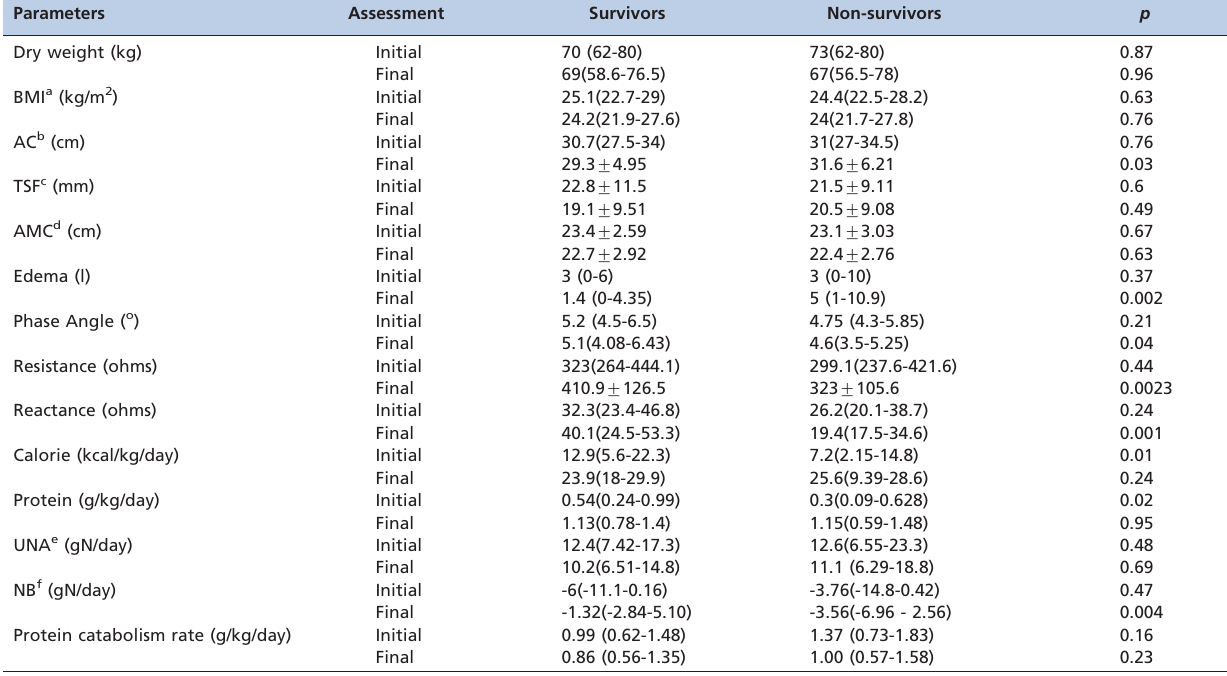
Table 3 - Nutritional parameters at the initial and final assessments in the survivors and non-survivors.